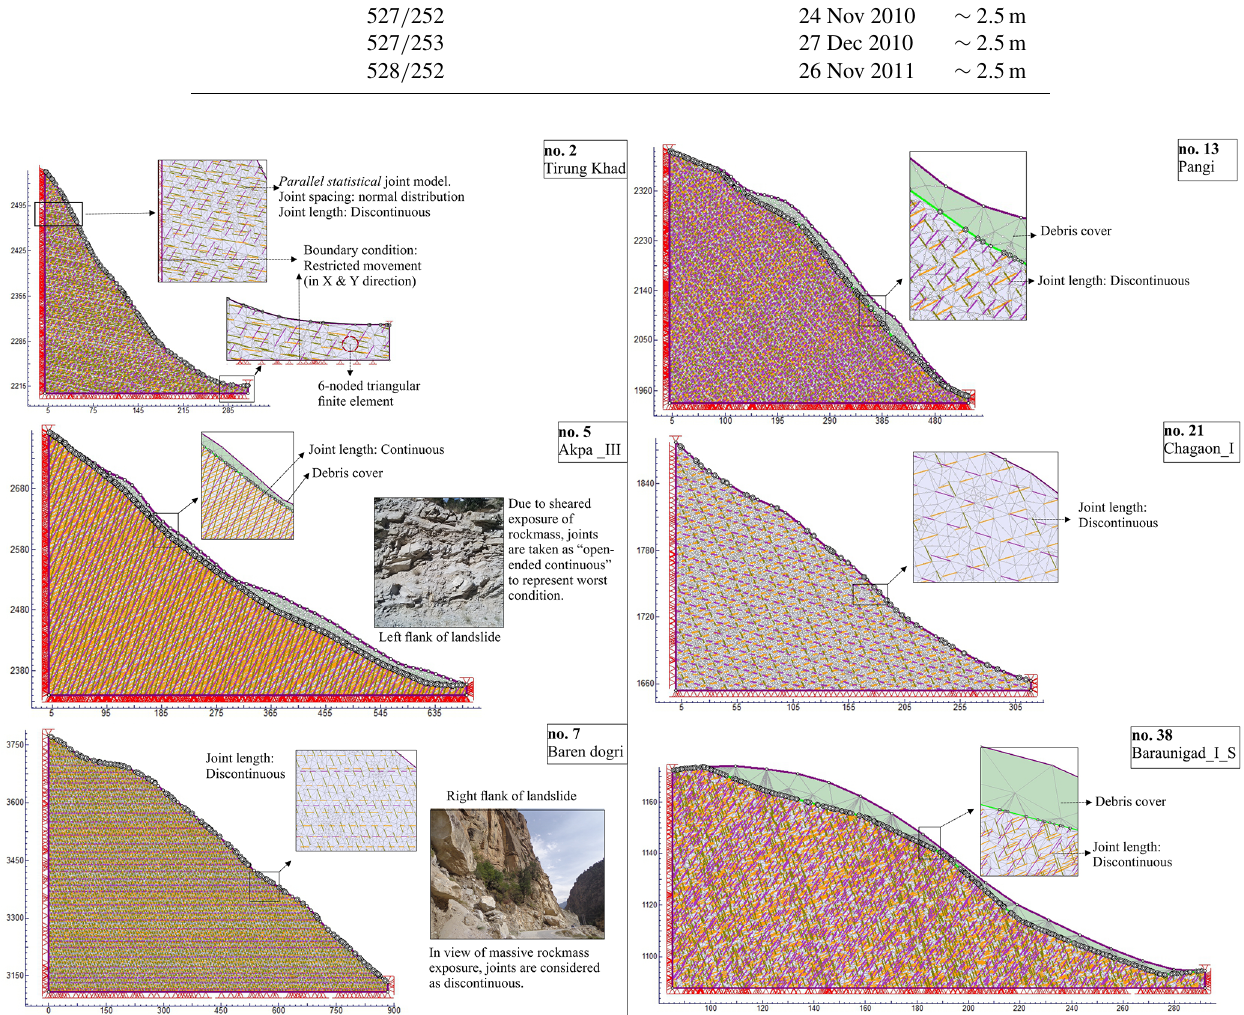
Figure 3. The FEM configuration of some of the slope models (no. refers to the serial no. of landslides in Table 1). The joint distribution in all the slopes was parallel statistical with the normal distribution of joint